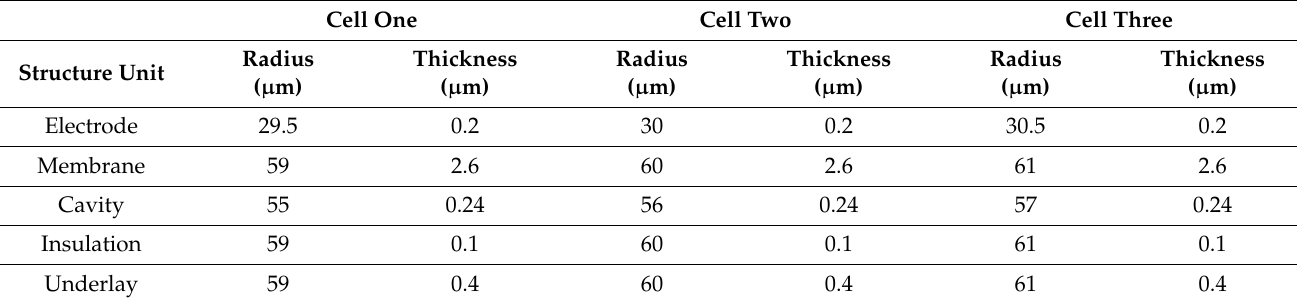
Table 3. Cell parameters of the three cell CMUT